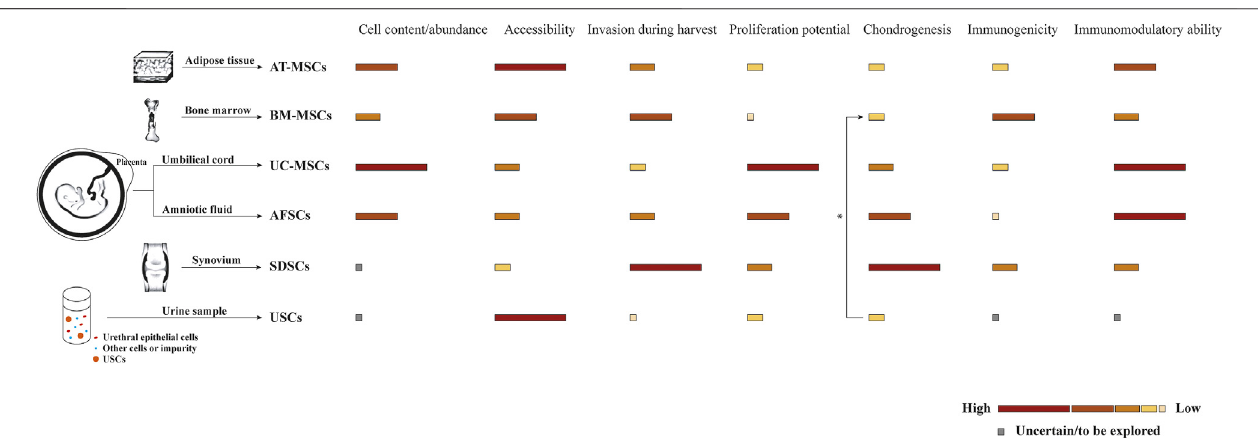
FIGURE 3 | Comparison of stem cells from different sources commonly used in scaffold-based osteochondral (OC) tissue engineering strategies. Biological characteristics are shown as different color blocks from high to low, inspired by Zha et al. (2021). * USCs are reported to promote the chondrogenesis of BM-MSCs by paracrine action in the co-culture system (Gao et al.,